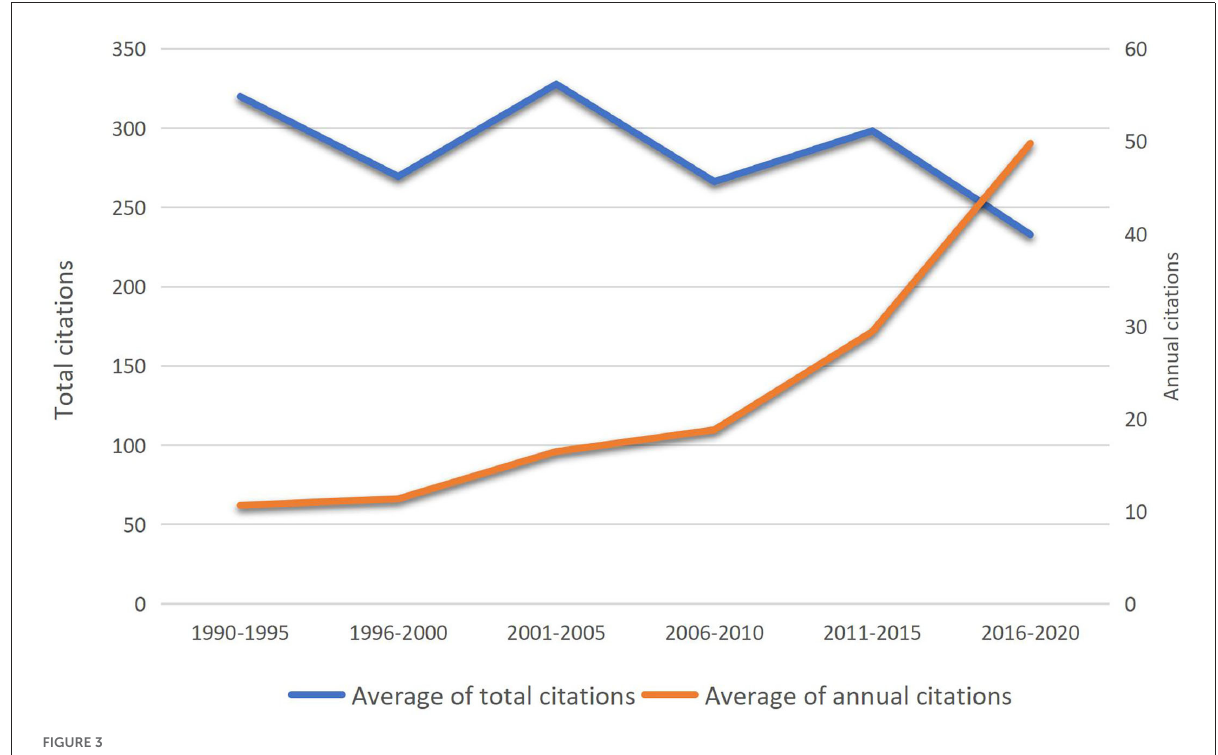
FIGURE3 The average of total citations and annual citations in each 5-year